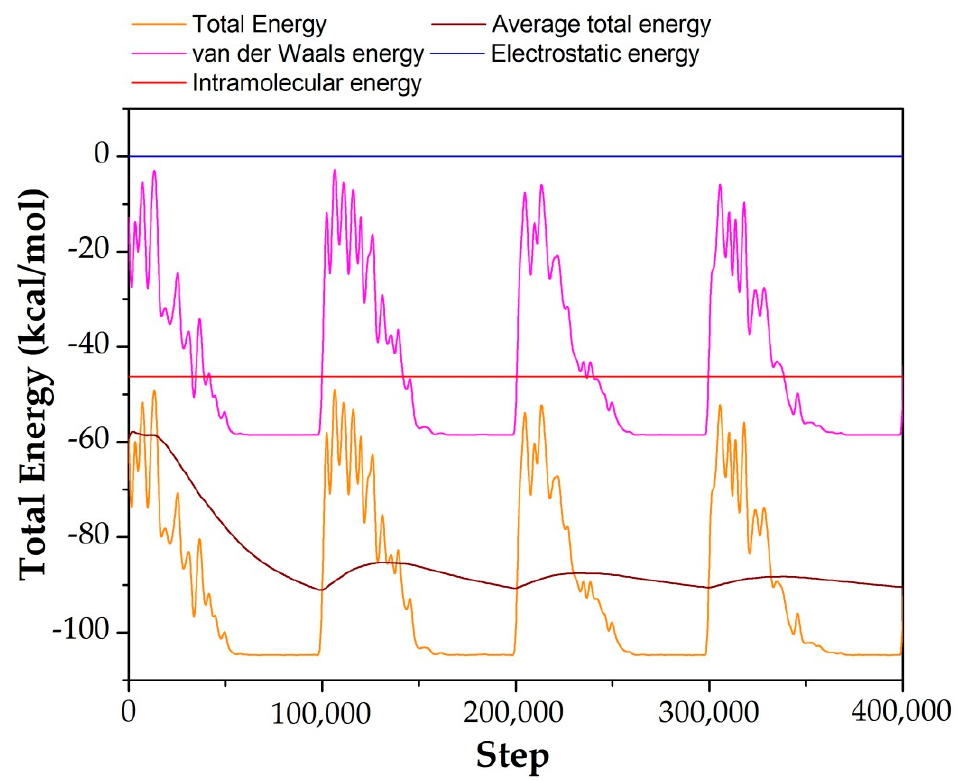
Figure 3. Total energy profile for Thr/Fe (100) system during the energy optimization process.